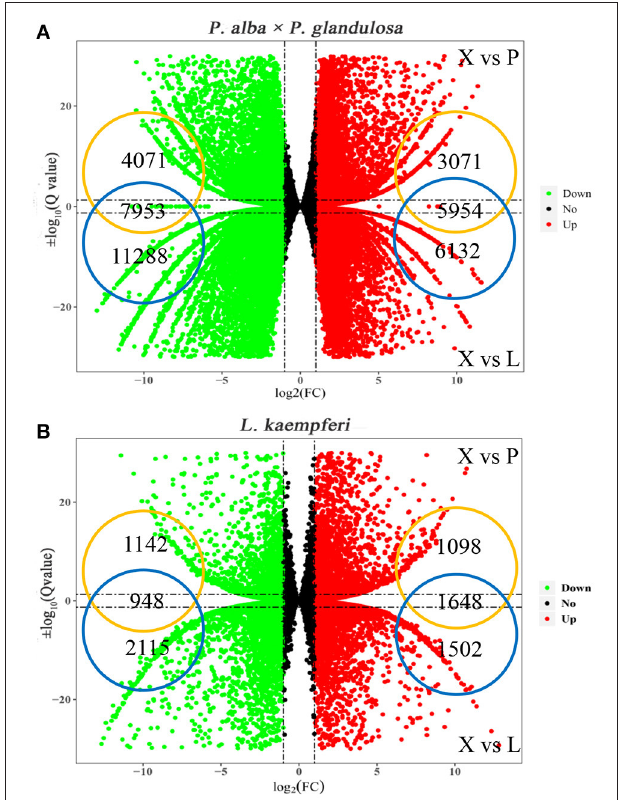
FIGURE 2 | Distributions of up- and down-regulated DEGs in the two tree species. (A) Up and down-regulated DEGs in P. alba × P. glandulosa . (B) Up and down-regulated DEGs in L. kaempferi . In both panels, X vs. P represents the differential expression analysis between the xylem and phloem; likewise, X vs. L represents the differential expressed analysis between the xylem and leaf. The vertical dotted lines correspond to the log 2 (fold- change) = ± 1, while the horizontal dotted lines are positioned at log 10 ( Q -value) = ± 1.3 ( Q -value = 0.05). The genes at the intersection of two groups are the up- and down-regulated genes in xylem